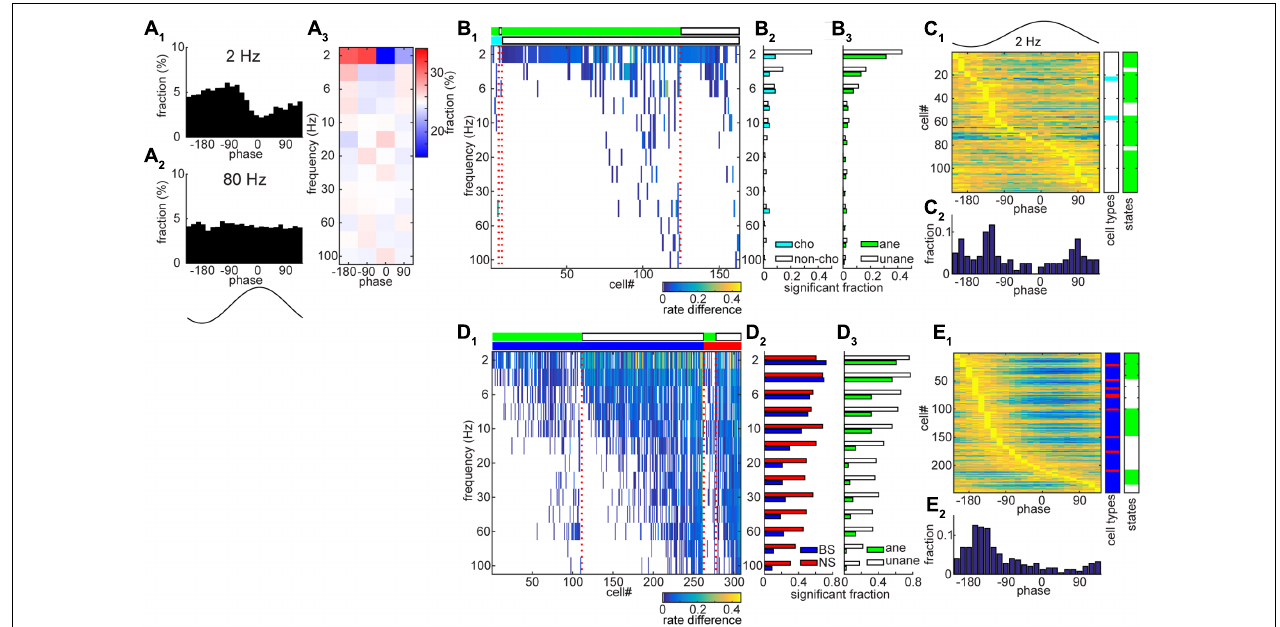
FIGURE 6 | Entrainment of spontaneous spike trains to rhythmic LPFs in the BF and AC. (A) An example of BF cell with showing rate modulation by slow (2 Hz) rhythmic LFPs. In (A 1 ) and (A 2 ) , the fraction of spikes is shown as a function of LFP phase at a particular frequency band. In (A 3 ) , phase bins were divided into four phases and the fraction of spikes was color-coded. (B) A summary of rate modulations across frequency bands in the BF. In (B 1 ) , rate difference was defined as the difference in the fraction of spikes at between the peak phase and 180 ◦ opposite phase. Rate difference was color-coded only at frequencies with significant modulation ( p < 0.01, Rayleigh’s test). Different experimental conditions (light green, anesthetized; white, unanesthetized) and cell types (cyan, cholinergic cells; white, non-cholinergic cells) are shown in the top bars, respectively. In (B 2 ,B 3 ) the fraction of cells which showed significant modulations was shown. No significant difference in the distribution was detected ( B 2 , p = 0.98; B 3 , p = 0.99, chi-square goodness-of-fit test). (C) Phase modulations of BF cells at 2 Hz. The fraction normalized by the peak value was shown in (C 1 ) with information about cell types and experimental conditions. In (C 2 ) the distribution of peak phases was shown. (D) A summary of rate modulations across frequency bands in the AC. In (D 1 ) , rate difference was color-coded. Different experimental conditions (light green, anesthetized; white, unanesthetized) and cell types (blue, BS cells; red, NS cells) are shown in the top bars, respectively. In (D 2 ,D 3 ) the fraction of cells